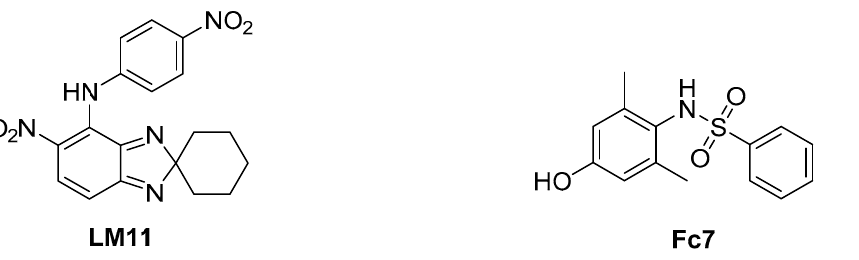
Figure 1. Structure of LM11 and Fc7 , two inhibitors of ADP-ribosylation factor-1 (Arf1) activation by Arf nucleotide-binding site opener (Arno).